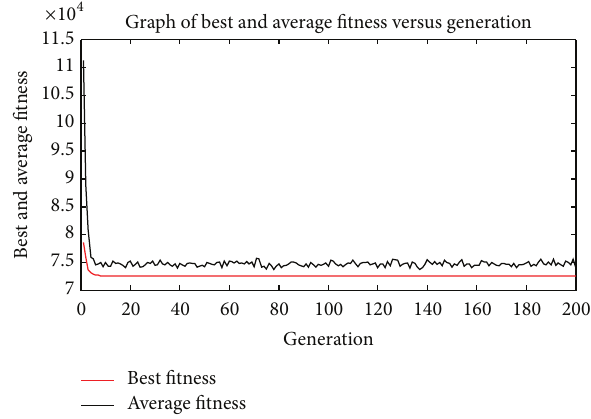
Figure 3: Best and average fitness versus generation of the aircraft maximum takeoff weight (MTOW).